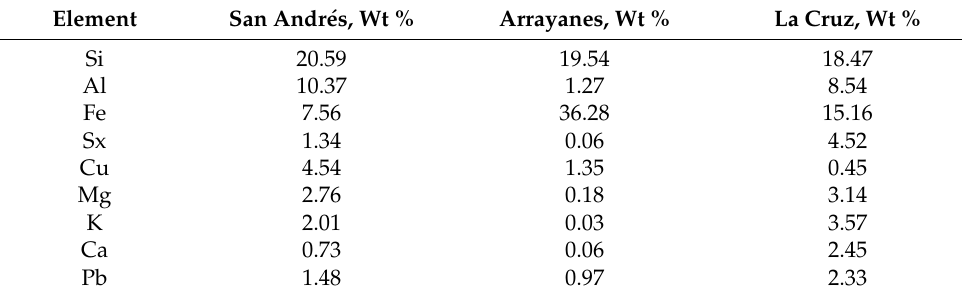
Table 2. Micro-X-ray fluorescence of the waste dumps in study.